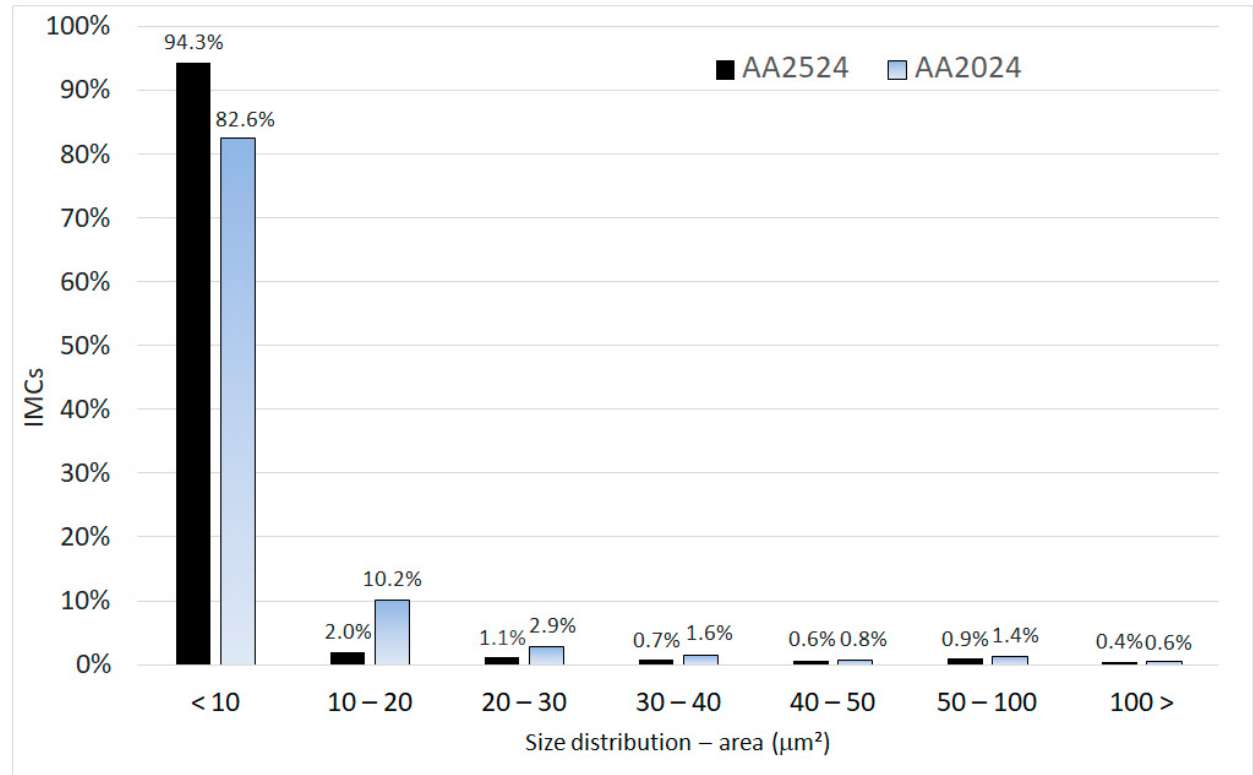
Figure 3. Frequency (%) and size distribution (µm 2 ) of IMCs for as-received samples. More than 94% of the AA2524-T3 alloy and 82% of the AA2024-T3 alloy IMCs are smaller than 10 µm 2 . Table 3. Comparison of IMCs area fraction of AA2024 and AA2524 alloys.